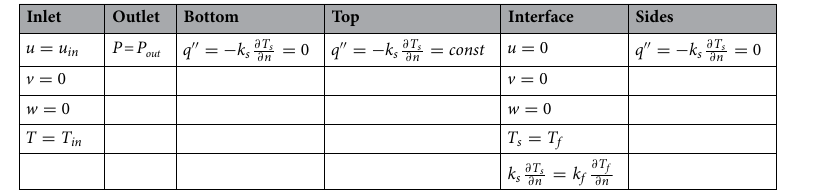
Table 3. Boundary conditions of the microchannel heat